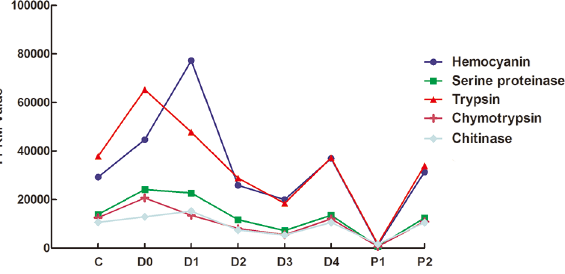
Fig 6. Expression profiles of hemocyanin, serine proteinase, trypsin, chymotrypsin, and chitinase. The x-axis represents developmental stages. The line represents the total fragments per kilobase of exon per million fragments mapped (FPKM) for the